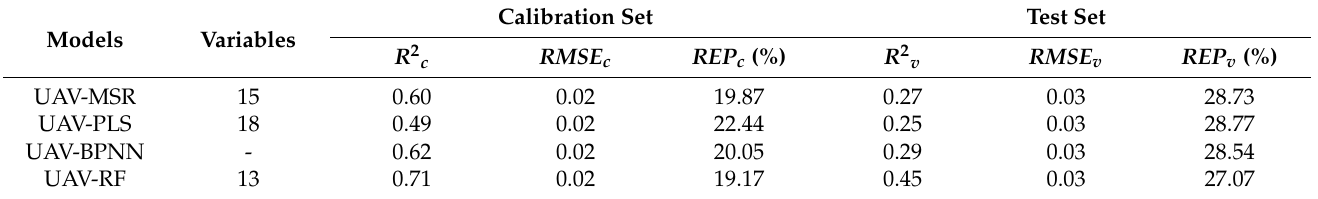
Table 8. Anth estimation model based on unmanned aerial vehicle (UAV) parameters.